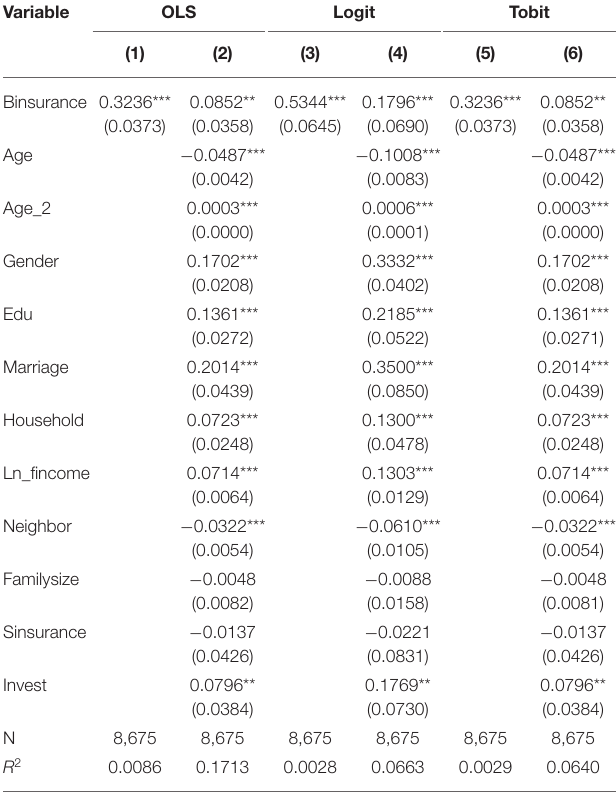
TABLE 3 | Benchmark